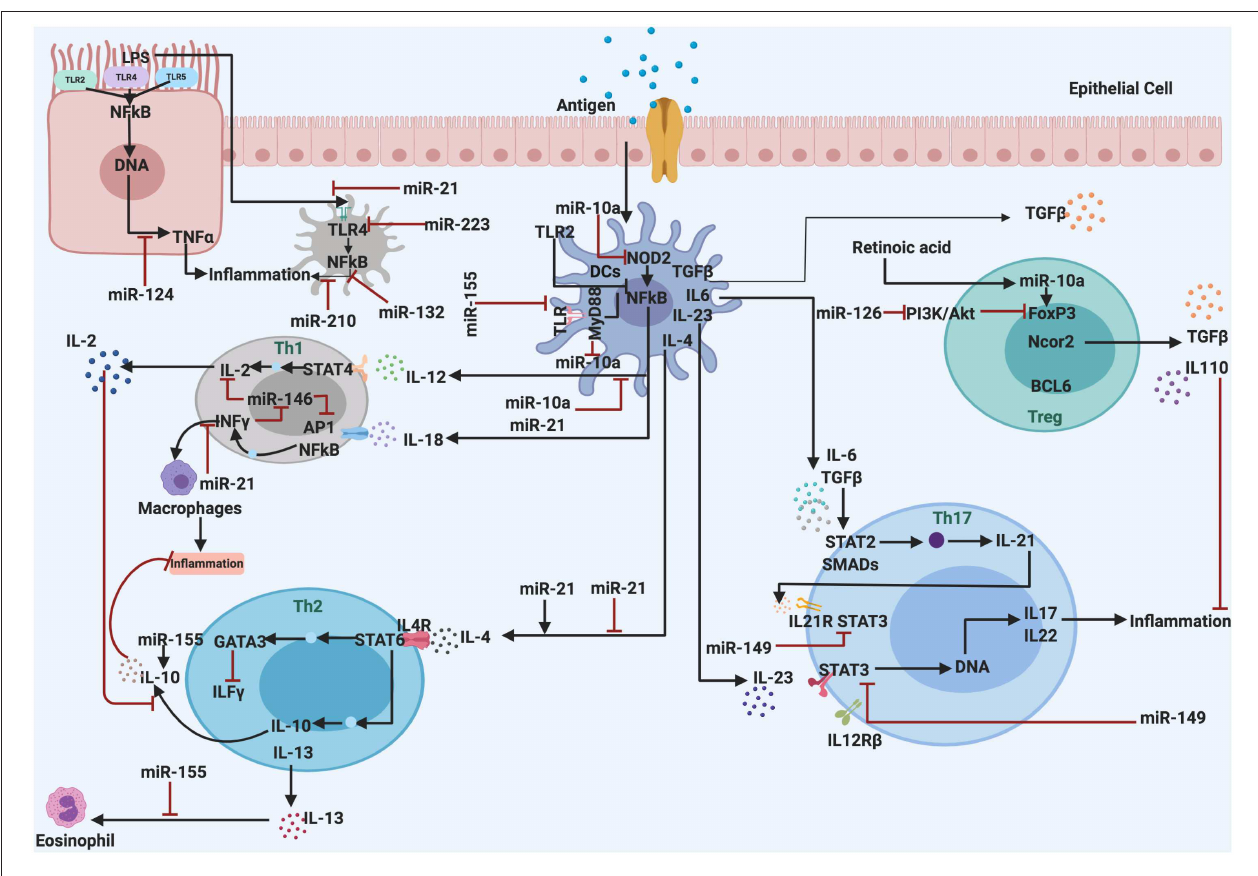
FIGURE 2 | The miRNAs are associated with regulation and control the inflammatory response. They act as anti-inflammatory miRNAs, serve in important negative feedback loops in inflammation processes and inflammatory diseases. By targeting signal transduction proteins involved in the initiation of the innate